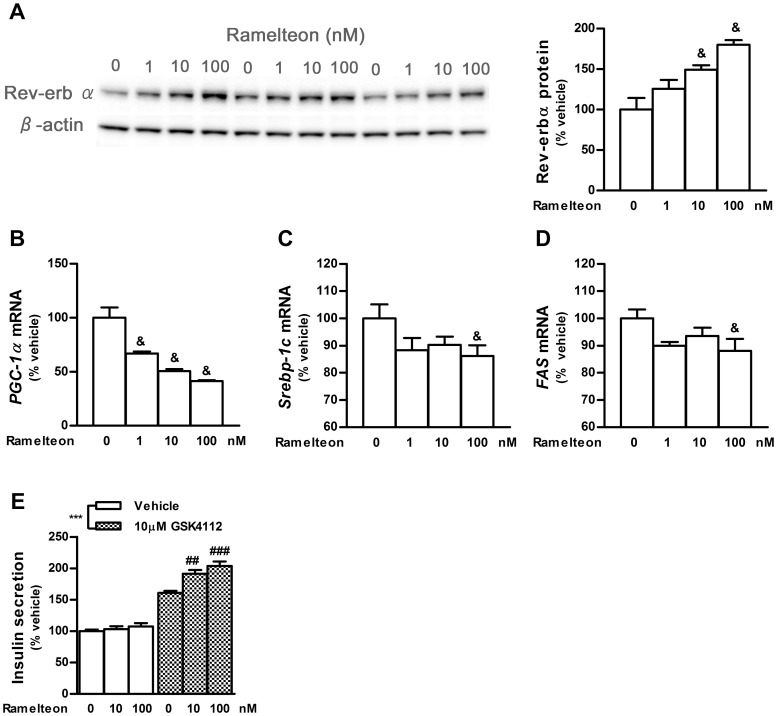
Activation of Rev-erbα signaling by ramelteon treatment for 14 h.INS-1 cells were treated with ramelteon (1, 10, or 100 nM) for 14 h. (A) Expression levels of Rev-erbα protein were detected by western blot analysis. (B–D) Expression of Rev-erbα-regulated genes (PGC-1α, Srebp-1c, and FAS) was measured using TaqMan polymerase chain reaction and normalized to that of the housekeeping gene cyclophilin A. (E) After ramelteon (10 or 100 nM) treatment for 14 h, the cells were washed and stimulated with the Rev-erbα agonist GSK4112 (10 µM). After 30 min, the amount of insulin secretion was measured. Data are presented as means ± SEM (A, n = 3; B–D, n = 4; E, n = 6) and were analyzed using Williams' test (A–D) or 2-way analysis of variance followed by Dunnett's test (E). &
P<0.025 vs. vehicle-treated control; ***
P<0.001, vehicle vs. GSK4112 treatment; ##
P<0.01, ###
P<0.001 vs. GSK4112-treated control.